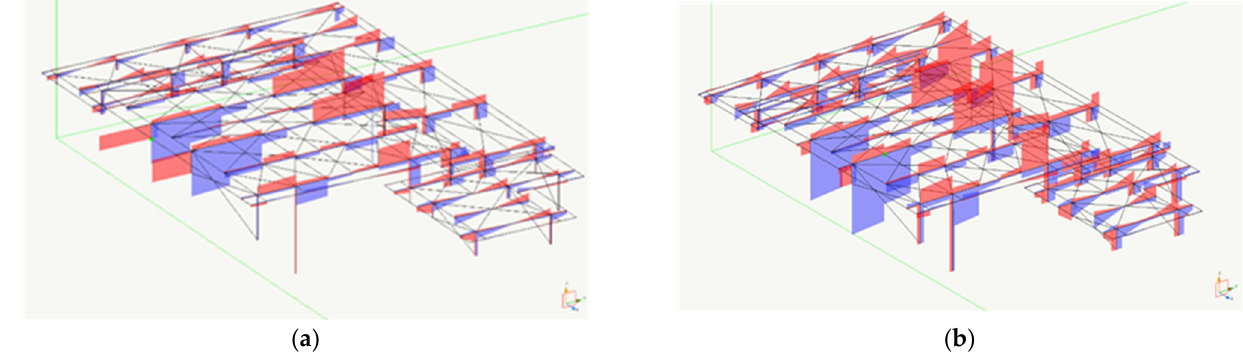
( b ) Figure 17. The structural models of the roofs. ( a ) Championnet n.1-2; ( b ) Championnet house at n.3. At the base of the columns, the bearing device was modeled with elements having the stiffness of the Elastofip 1.5 EF 7.2. The structural detail was designed according to Italian seismic code NTC2008 [12]. The local bearing capacity of the masonry walls were verified according to Eurocodes and the possible overturning mechanisms were assessed according the limit analysis [16]. Figure 13 shows the structural design of the details, while Figures 14 and 15 show the structural elements on place during construction. 3.3.1. Efficiency Analysis The efficiency of the structural designed was performed. In the following, a compar- ison between the isolated structure at the base and a fixed base structure (the same struc-